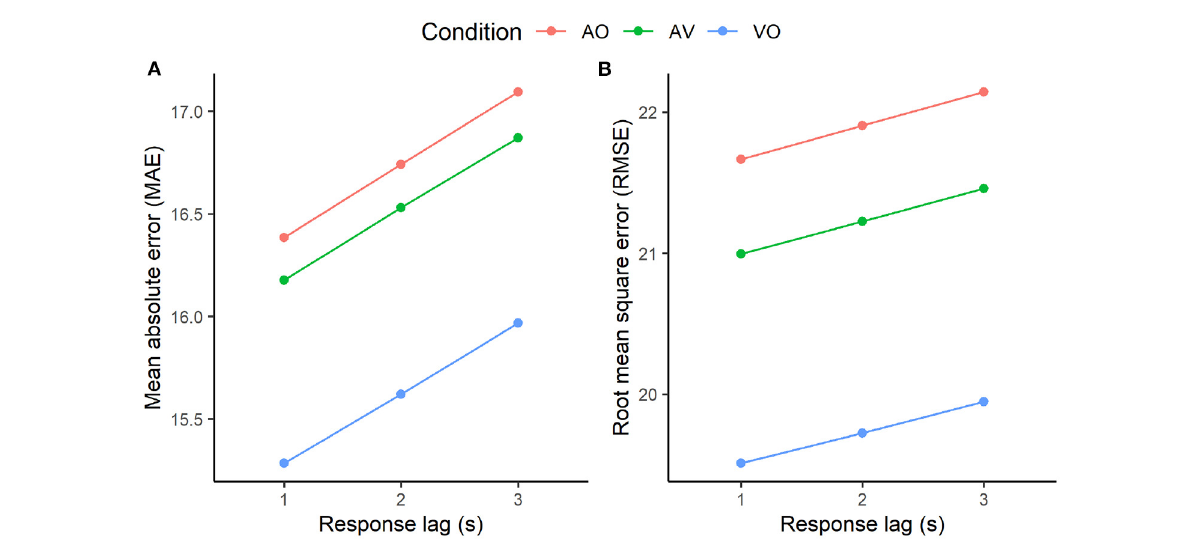
FIGURE6 K-fold cross-validation accuracy of models computed at different response lag times (i.e., 1, 2, and 3 s lag) for the audio only (AO), video only (VO), and audio plus video (AV) conditions. Model accuracy was measured in terms of mean absolute error (MAE, A ) and room mean square error (RMSE, B